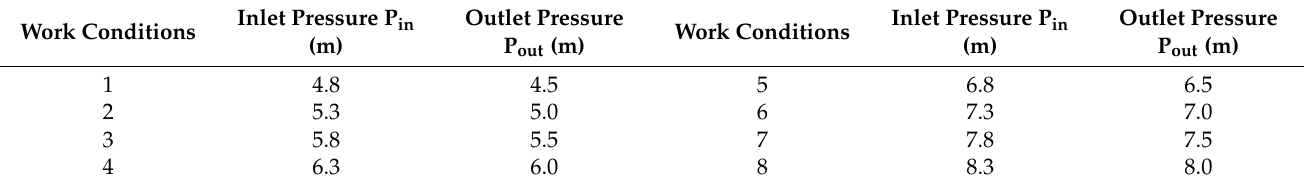
Table 6. Weir head under simulated working